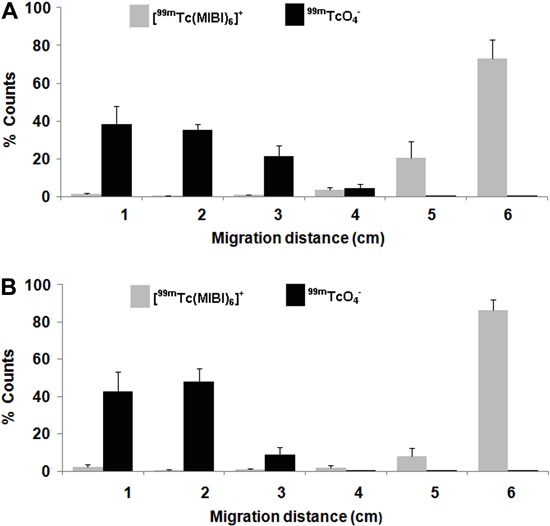
Paper chromatography of 99mTcO4
- and [99mTc(MIBI)6]+ in Whatman 1
(W1) regular paper (A) and W1 modified paper (B)
reported as percent of counts in segments of the chromatographic strip (cm),
numbers 1 to 6. Anhydrous ethanol was used as the mobile phase. W1 modified paper
is W1 paper washed with anhydrous ethanol. Data are reported as means±SD for n=18
(A) or n=11 (B).